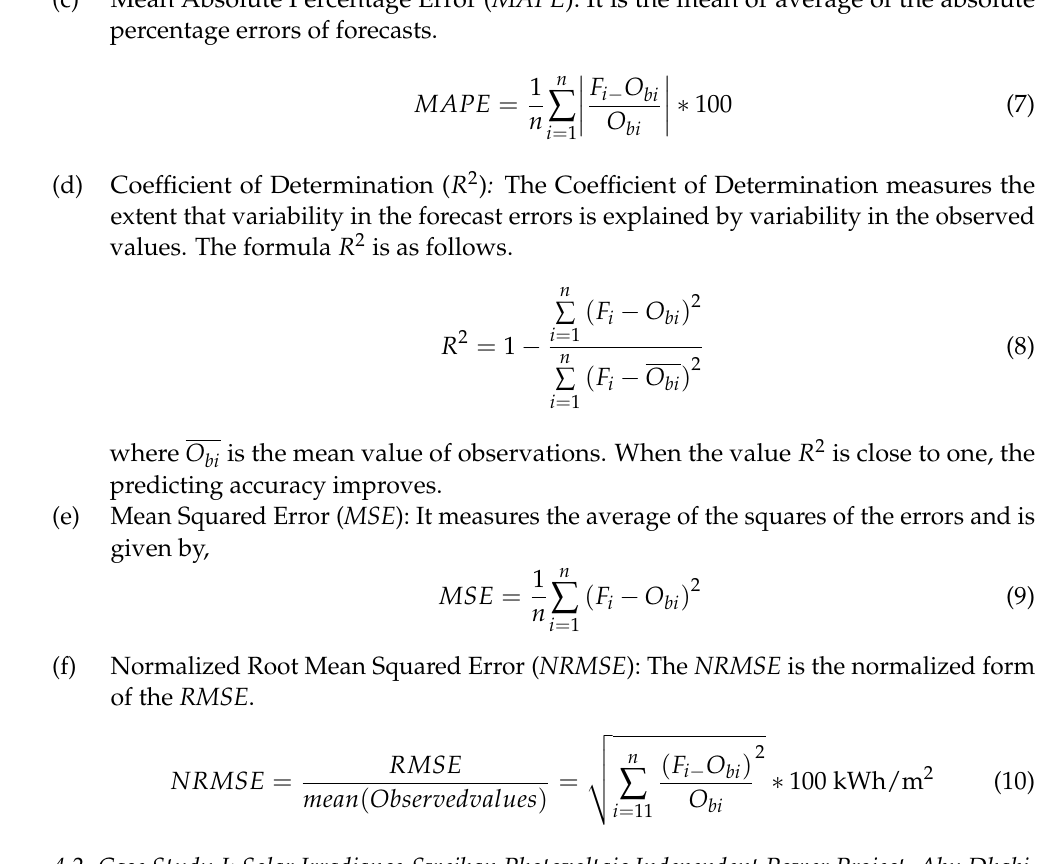
(f) Normalized Root Mean Squared Error ( NRMSE ): The NRMSE is the normalized form of the RMSE